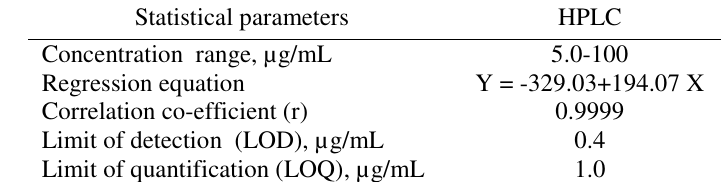
Figure 2. (B) Adefovir_dipivoxil –R.T: 4.357. Table 1. Results of the data analysis for the quantitative determination of adefovir dipivoxil by the proposed